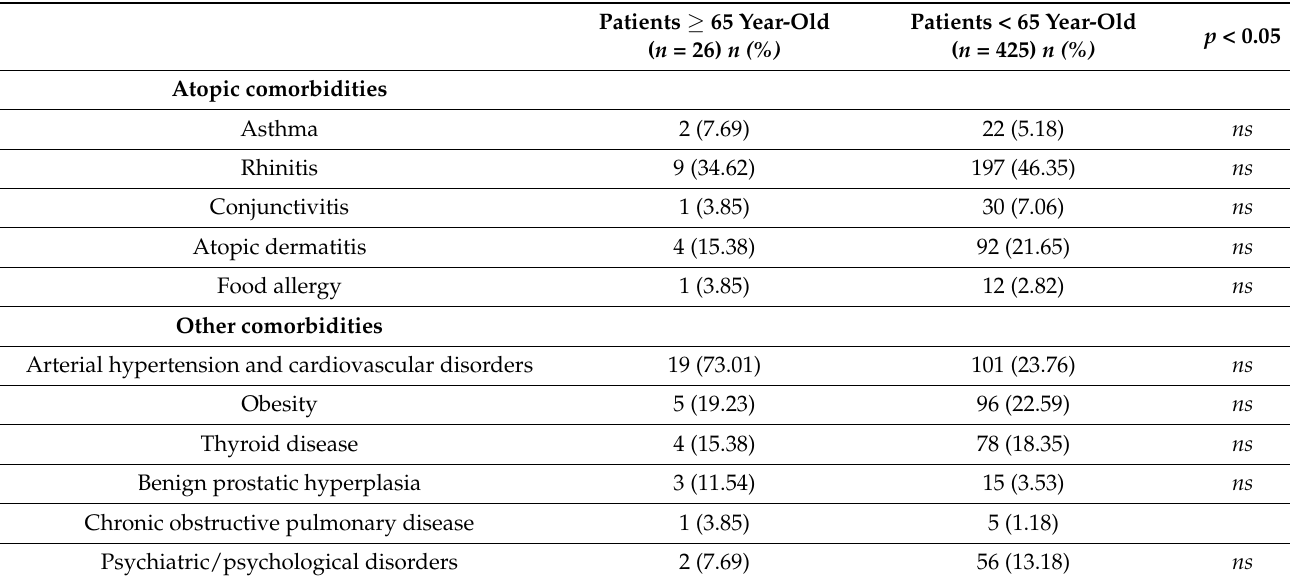
Table 4. Comorbidities of patients with